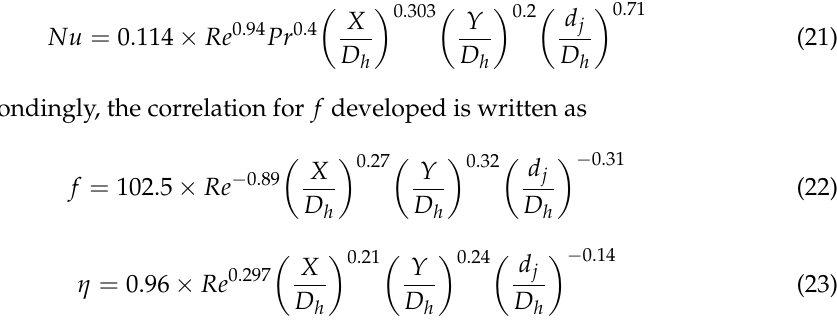
Figure 13. Comparison of η for present and various geometries investigated.